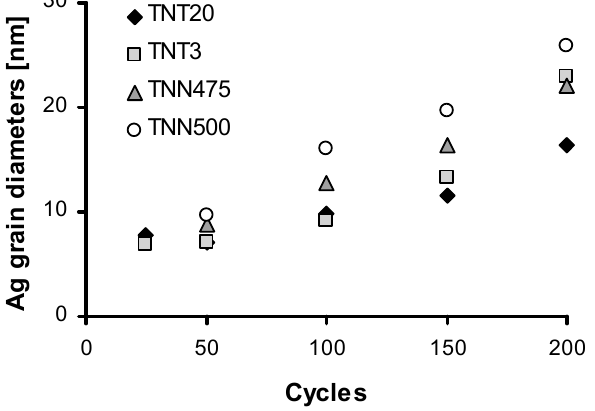
Figure 10. The dependency between the number of cycles and silver grain diameters.